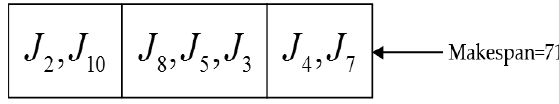
Figure 2. The obtained makespan by Algorithm 1.